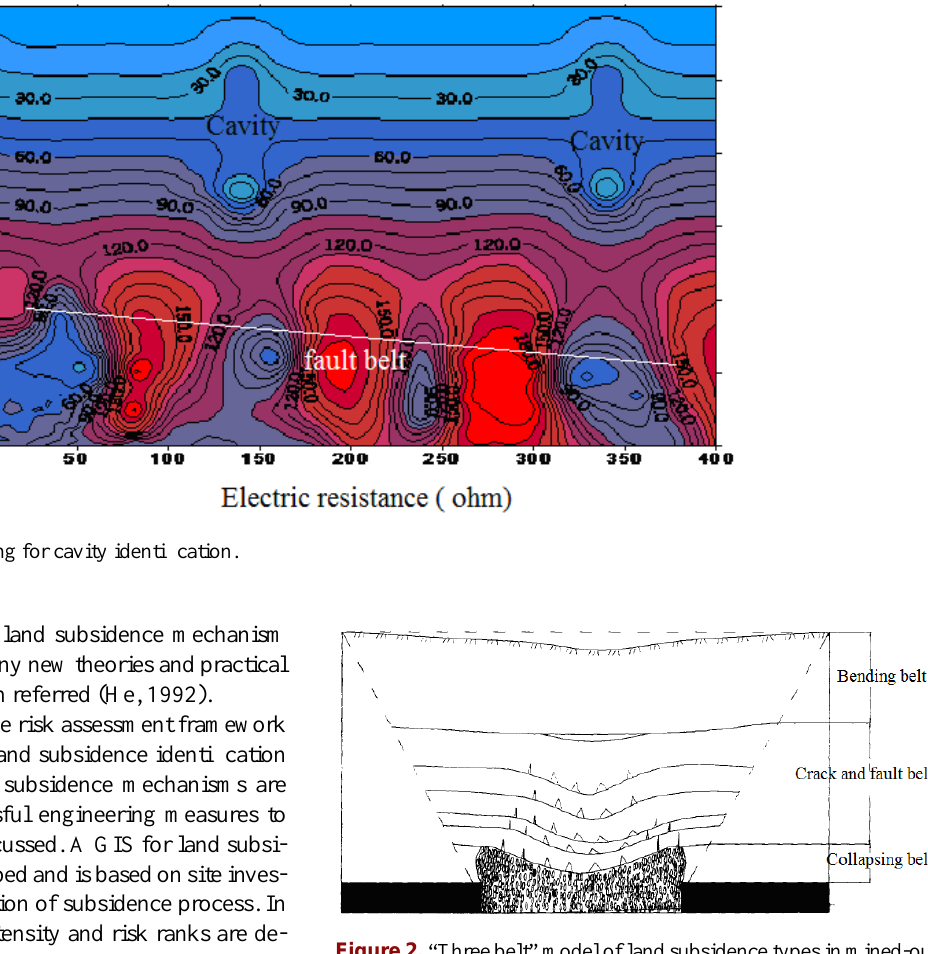
Figure 2. “Three belt” model of land subsidence types in mined-out